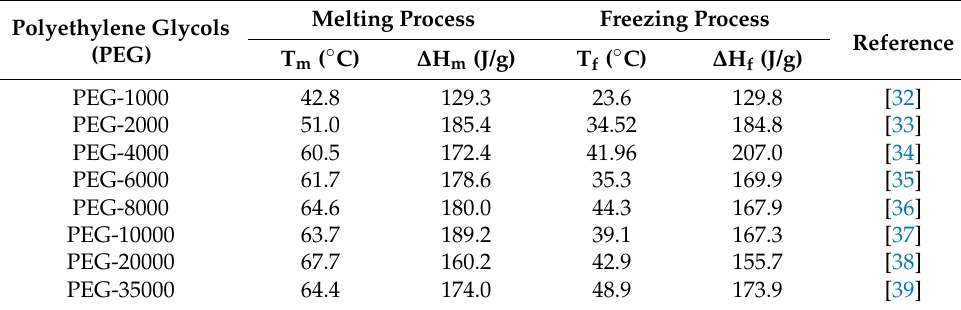
Table 1. Phase change properties of PEG with different molecular